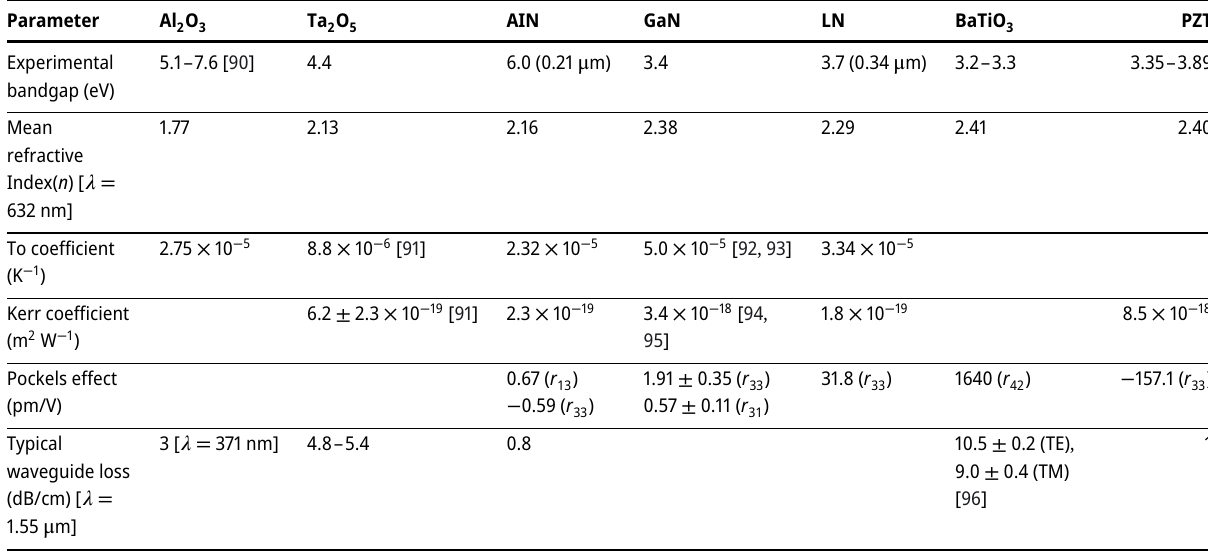
Table 2: Optical properties of typical wideband materials heterogeneously integrated on silicon platform. Parameter